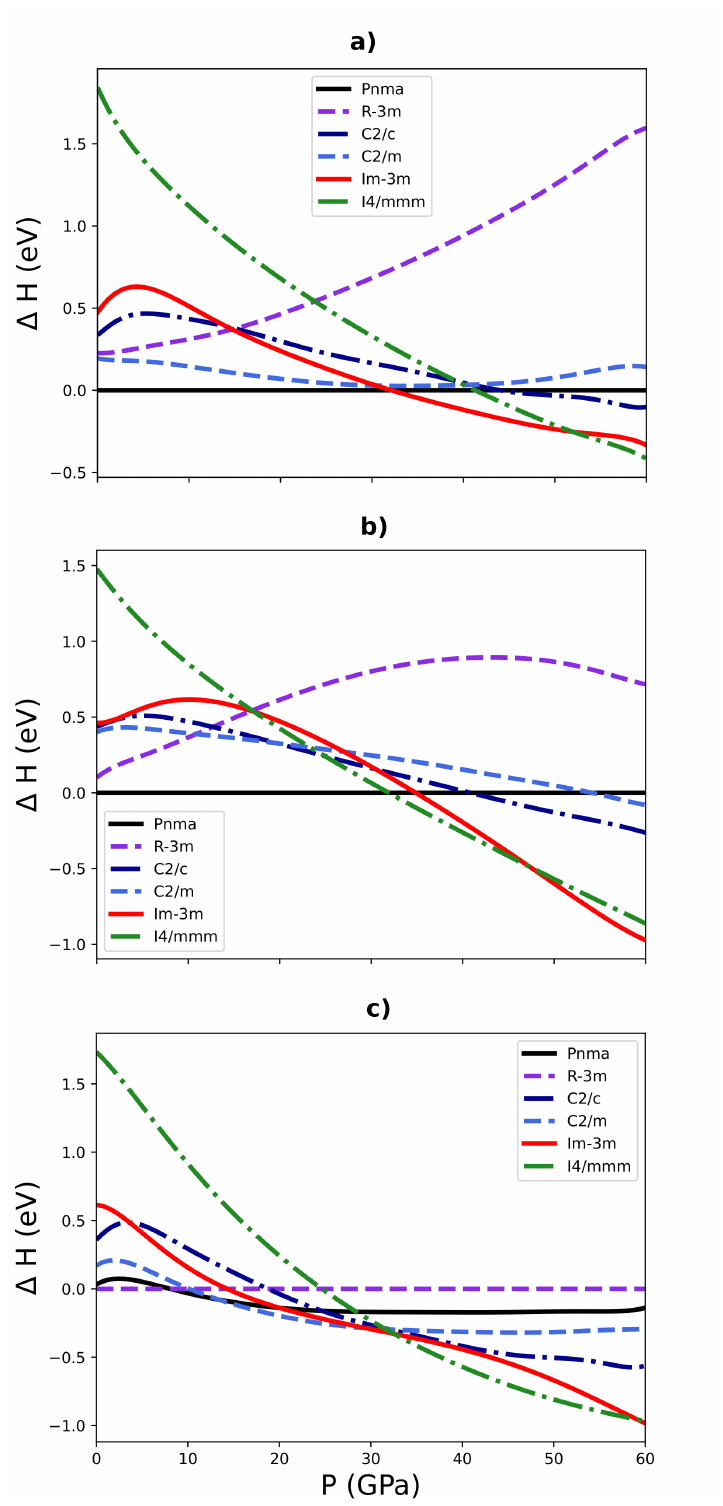
Figure A2. LDA enthalpy vs. pressure curves, for the different possible phases (shown in Figure 1) of Sb 2 S 3 ( a ), Bi 2 S 3 ( b ), and Sb 2 Se 3 ( c ), relative to the lowest-energy phase at ambient pressure: the Pnma phase for Sb 2 S 3 and Bi 2 S 3 , and the R-3m phase for Sb 2 Se 3